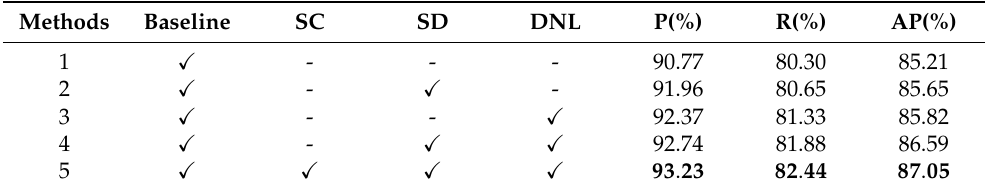
Table 2. Quantitative evaluation of the proposed schemes. (SC: scene classification, SD: saliency detection).